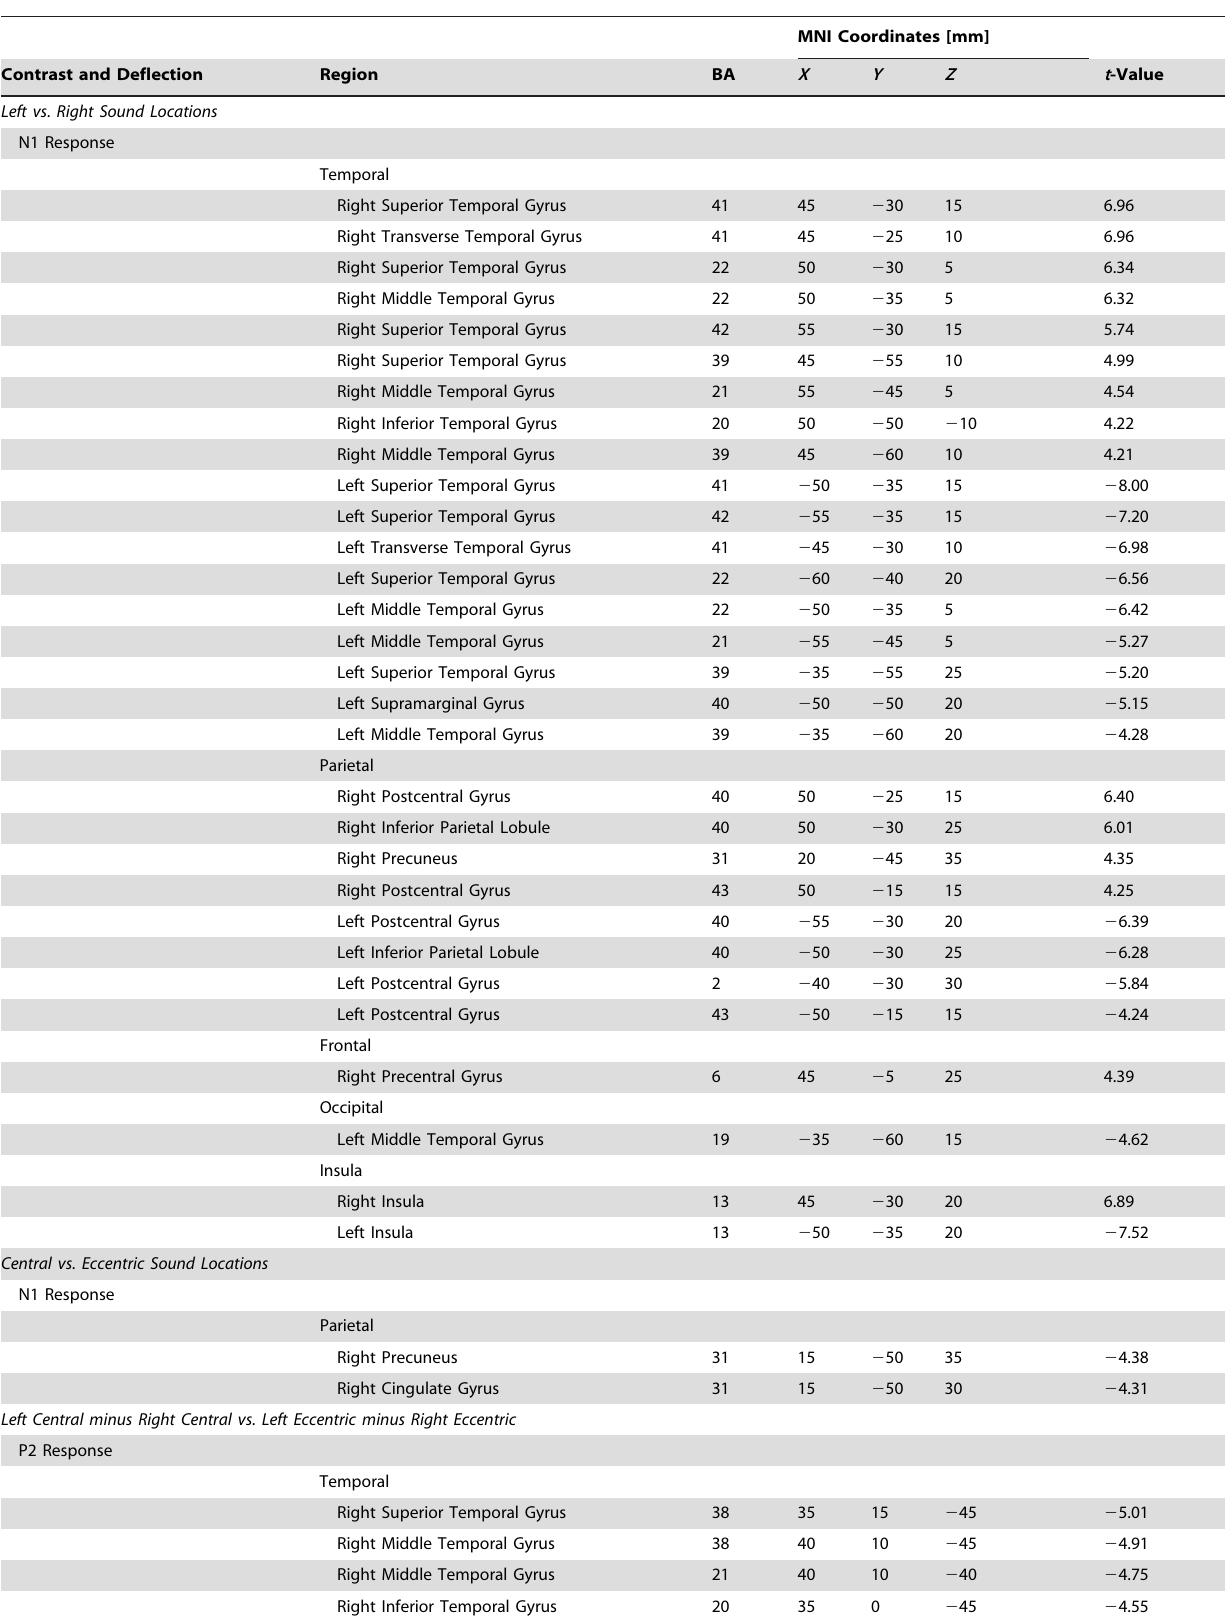
Table 3. Processing of left, right, central, and eccentric sound locations (all p , 0.05).